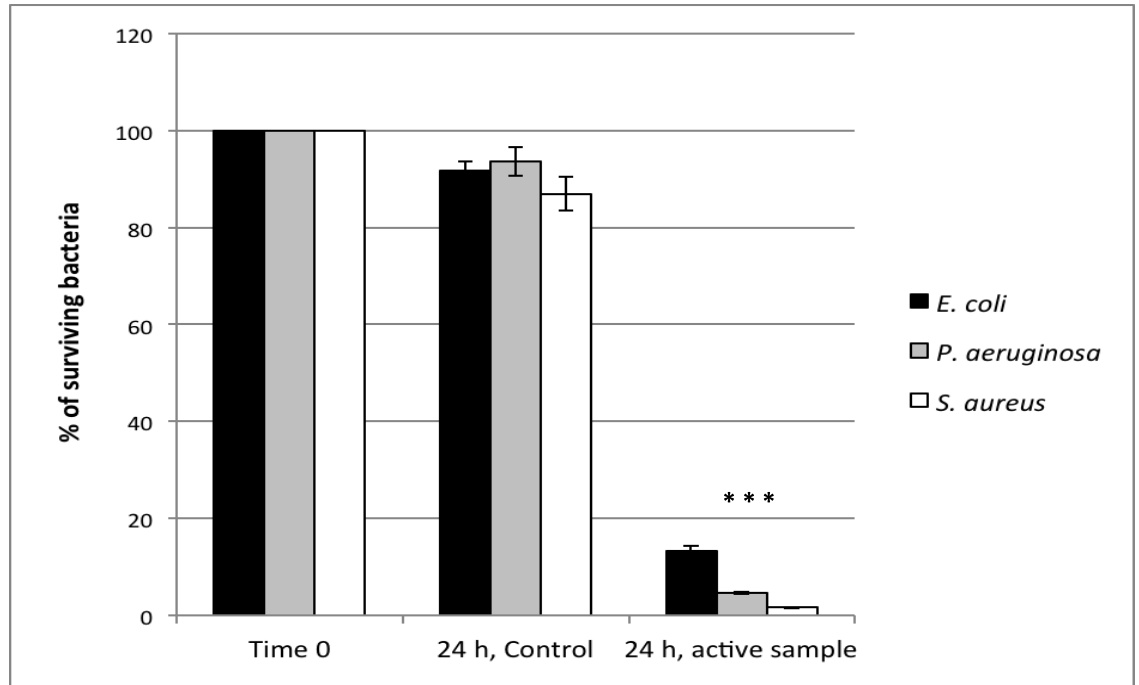
Figure 6. Percentage of surviving bacteria ( E. coli , P. aeruginosa and S. aureus ) on the control sample (without TiO ) and on the active sample (containing 2% w/w Aeroxide ® TiO 2 after 24 h of incubation at room temperature. The percentage of surviving bacteria was normalized to the inoculum (cells present at the beginning of the incubation). * p < 0.01 between T0 and T = 24